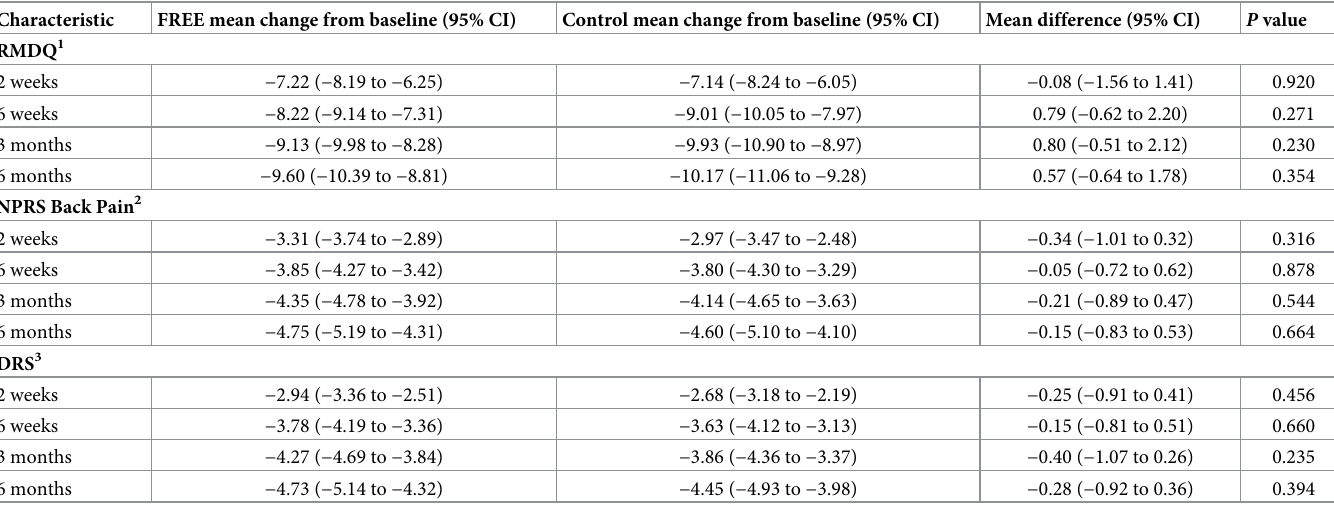
Table 3. Mean patient change scores at 2 weeks, 6 weeks, 3 months, and 6 months.